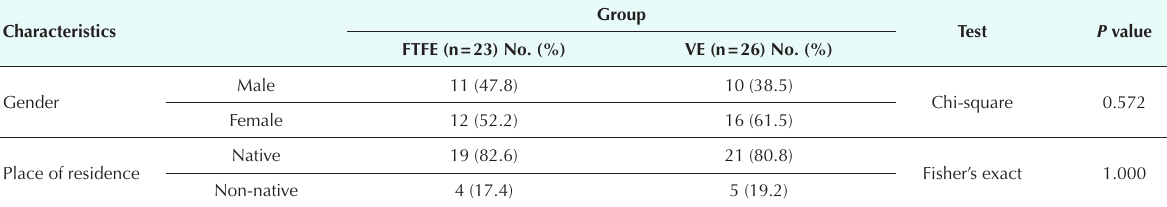
Table 1. Between-group comparisons respecting participants’ gender and place of residence Characteristics